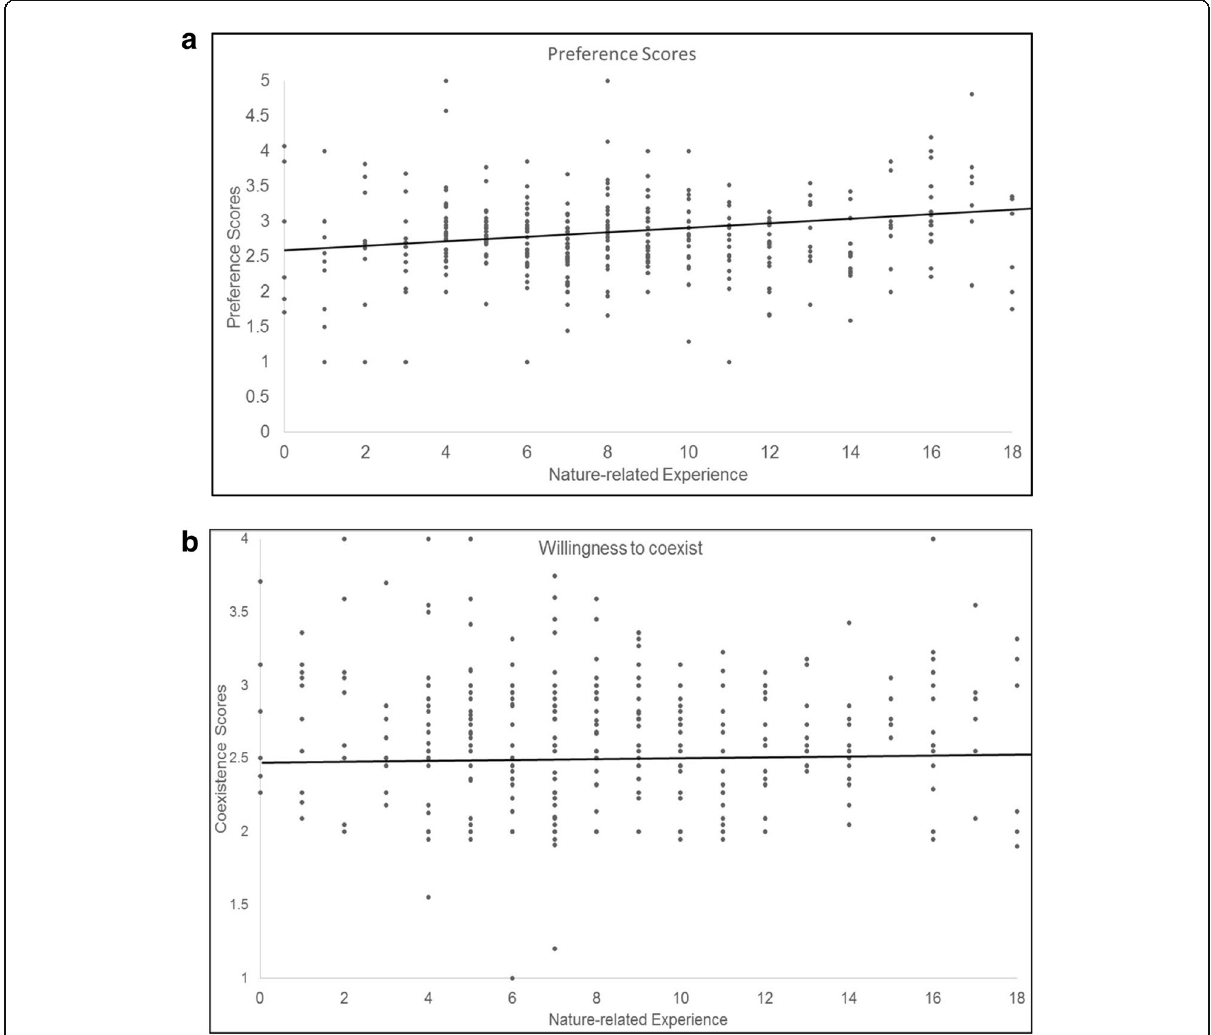
Fig. 6 Relationships between childhood nature experience and Preference and Coexistence scores. The linear regression line indicates the relationship between scores and nature experiences. a Relationships between childhood nature experience and Preference scores ( r = 0.13, p < 0.01). b Coexistence scores did not correlate with childhood nature experience ( r = 0.04, p =